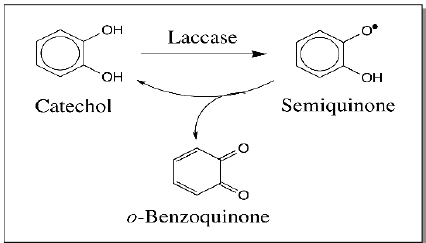
Figure 9. Laccase catalyzed oxidation of catechol. Laccase oxidizes catechols to the semiquinone. Two molecules of semiquinone undergo rapid disproportionation generating the starting material and quinone product.